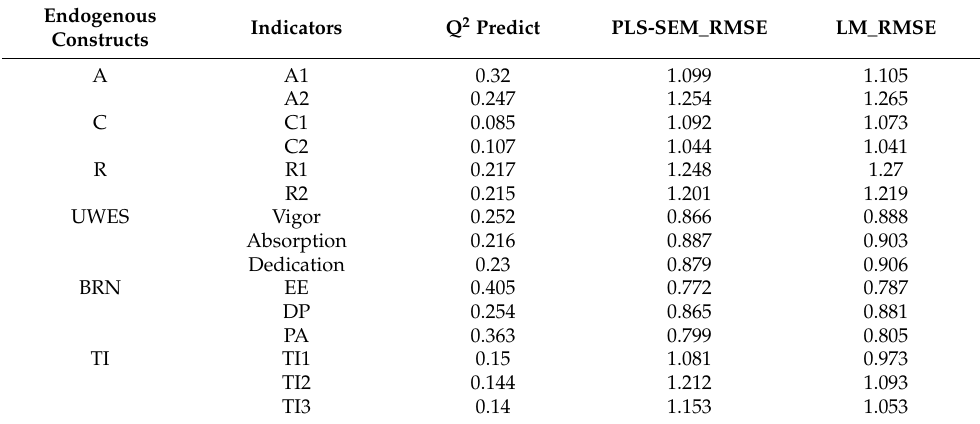
Table A8. Predictive Power of the Model.